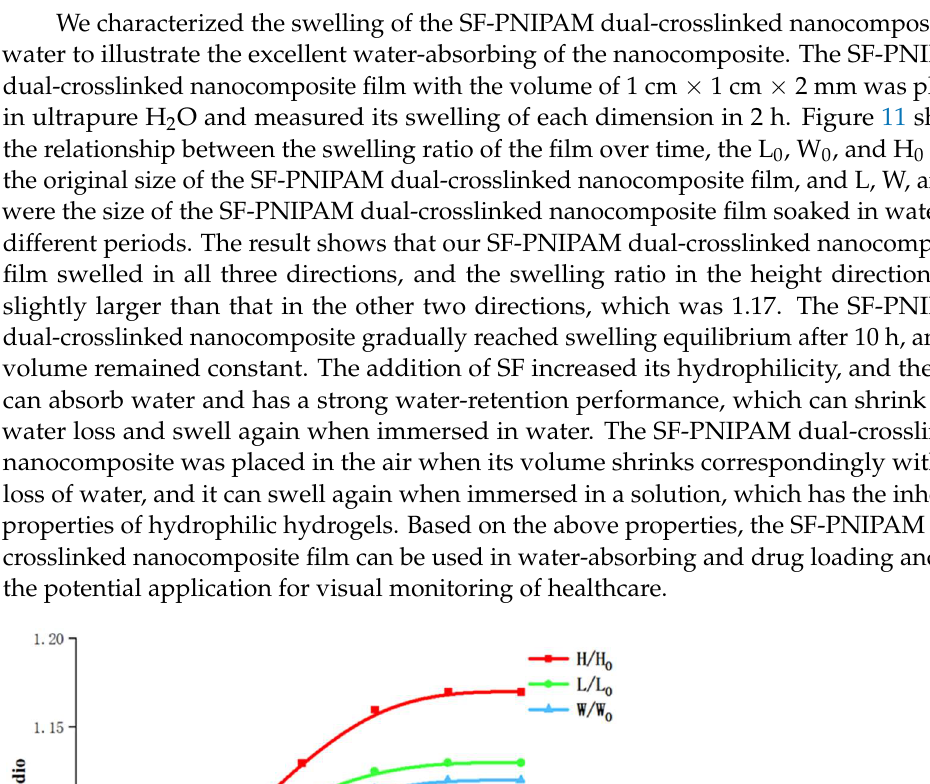
Figure 10. The reflection spectrum of the SF-PNIPAM dual-crosslinked nanocomposite in buffer solution ( a ) pH = 5; ( b ) pH = 9 (blue and red are the reflectance spectrum before and after the film was put into the acid-base buffer, respectively).